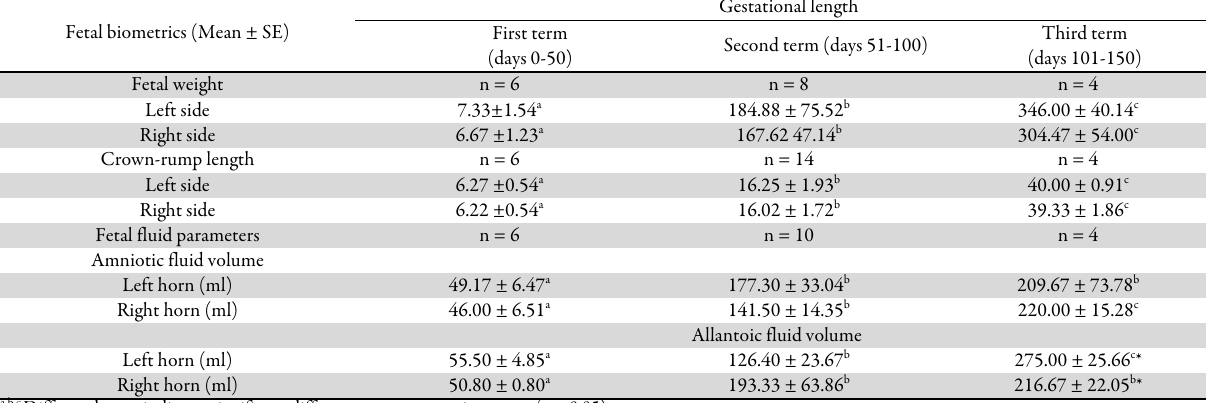
Asterix (*) within a column indicates significant differences between the left and right values (p <